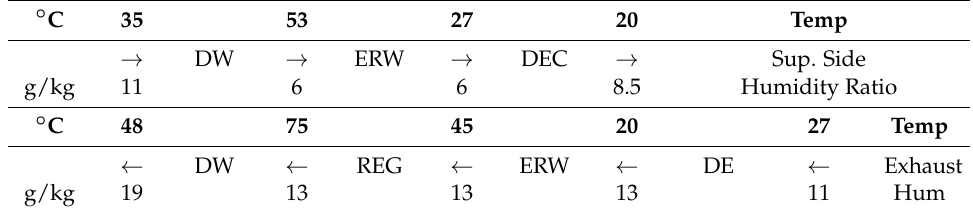
Table 1. Typical air-temperature and humidity levels at the inlet and outlet of each component of solid-desiccant evaporative air-cooling (SDEAC) system whose configuration is shown in Figure 1. DW: Desiccant wheel, ERW: Energy-recovery wheel, DEC: Direct evaporative cooler, REG: Regenerator.